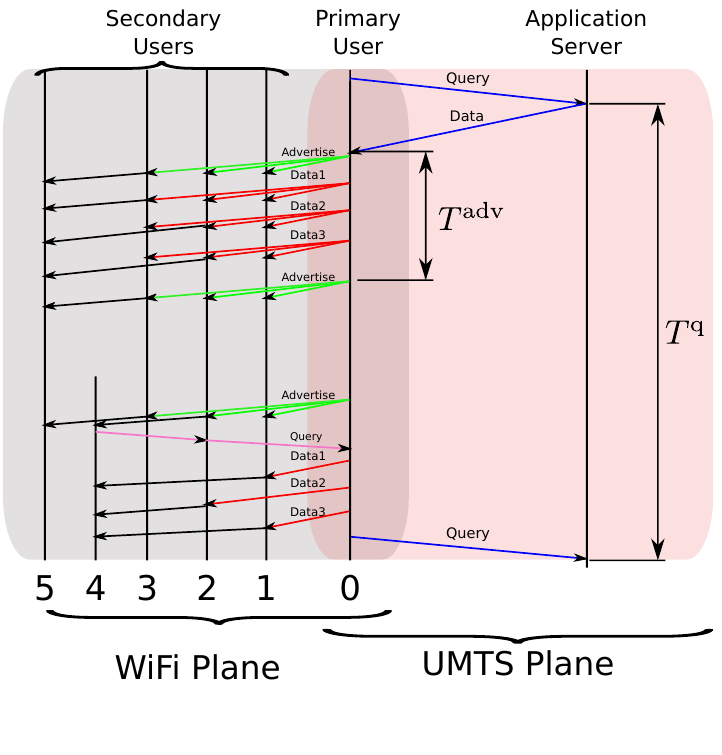
Figure 5. Temporal diagram of a generic X-NETAD message